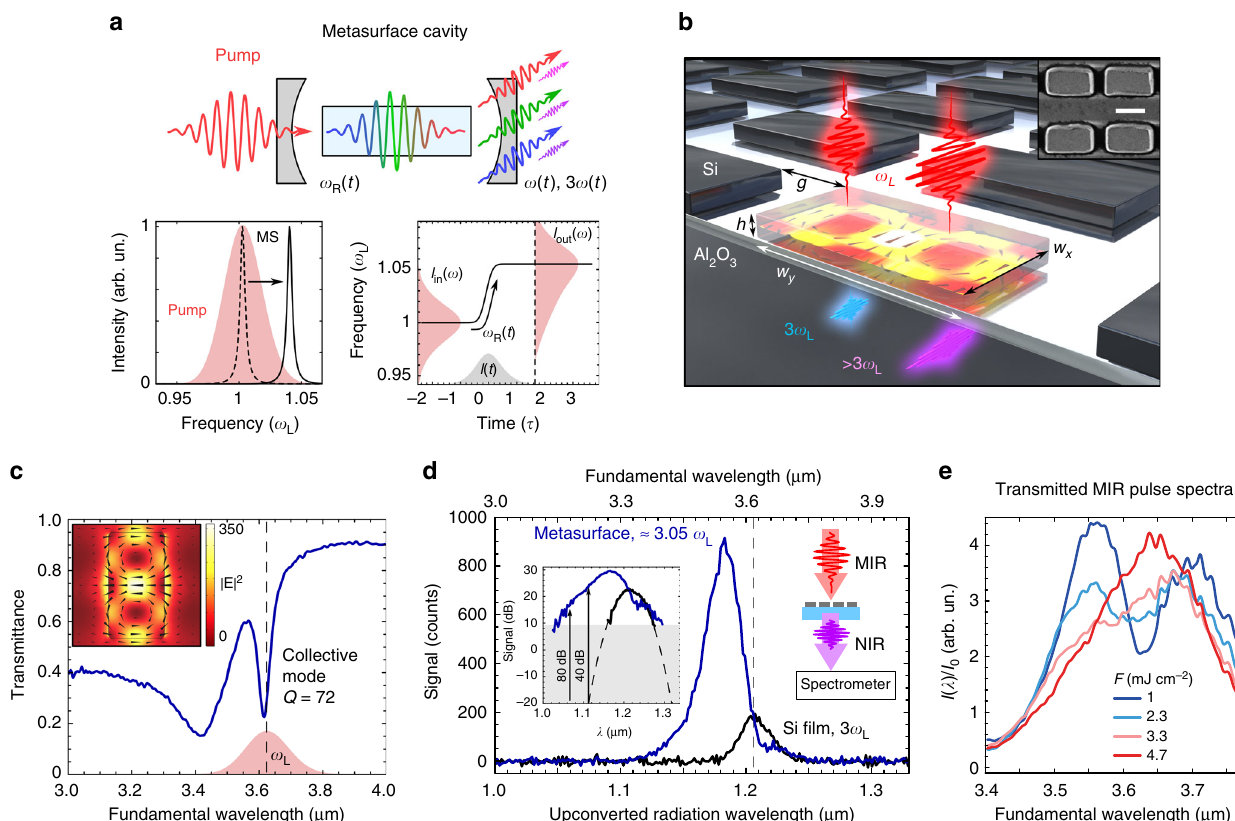
Fig. 1 Self-induced blue-shift of harmonics from a nonlinear photon accelerating semiconductor infrared metasurface (PASIM). a The concept of blue- shifted harmonics generation. Mid-infrared (MIR) photons are trapped by the metasurface (MS) cavity, blue-shifted by the rapid refractive index variation due to free carrier generation inside the MS, and then nonlinearly upconverted to near-infrared (NIR) photons via the standard THG process. The blue- shifted MIR and NIR photons then leave the MS, and their spectra are detected in transmission. Red shaded areas in the plots illustrate the radiation spectra, the gray area represents the temporal pro fi le of the incoming pulse. Solid and dashed curves illustrate the time-dependent nature of the MS resonance. b Schematic of the sample and the MIR beam setup. In experiments, the following dimensions of the sample were used: w x = 0.87 μ m, w y = 1.54 μ m, g = 400 nm, and h = 600 nm. Inset: a close-up scanning electron micrograph of the metasurface elements; scale bar: 1 μ m. c Transmittance spectra of the metasurface measured using Fourier-transform infrared spectroscopy. Dashed line: central wavelength λ L of the MIR fs pulses. Inset: simulated electric fi eld E (arrows) and intensity | E | 2 (color) inside a metasurface unit cell for the incident light at λ = λ L . The red region shows the Gaussian fi t to the spectrum of the pump pulses. d Experimentally measured third harmonic generation (THG) in the metasurface (blue curve) and in an unstructured Si fi lm (black curve) of the same thickness h . Both spectra are measured at the same MIR fl uence of F = 2.3 mJ cm − 2 (peak intensity I = 11 GW cm − 2 ). A notable blue-shift of the upconversion peak from the metasurface with respect to the expected THG is a result of the plasma-induced acceleration of MIR photons. Inset: the same data plotted on the logarithmic scale. Gray region: the noise fl oor. The THG from the metasurface extends to λ = 1.06 μ m, with intensities eight orders of magnitude higher than projected from the unstructured fi lm (Gaussian fi t given in dashed line): a clear indication of the emergence of the photons that are not present in the incident spectrum. e Spectra of MIR pulses transmitted through the metasurface for different input fl uences revealing signi fi cant pulse